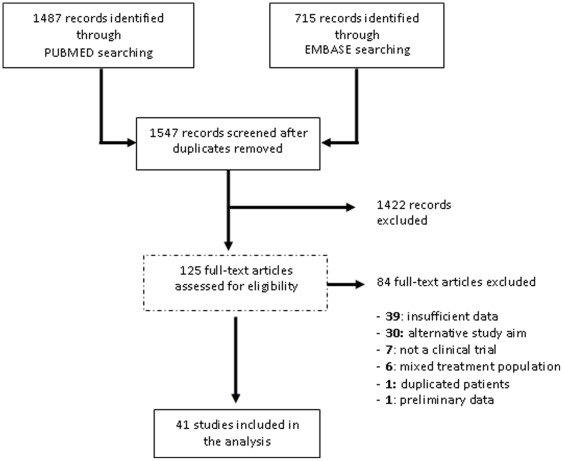
Search strategy and results.